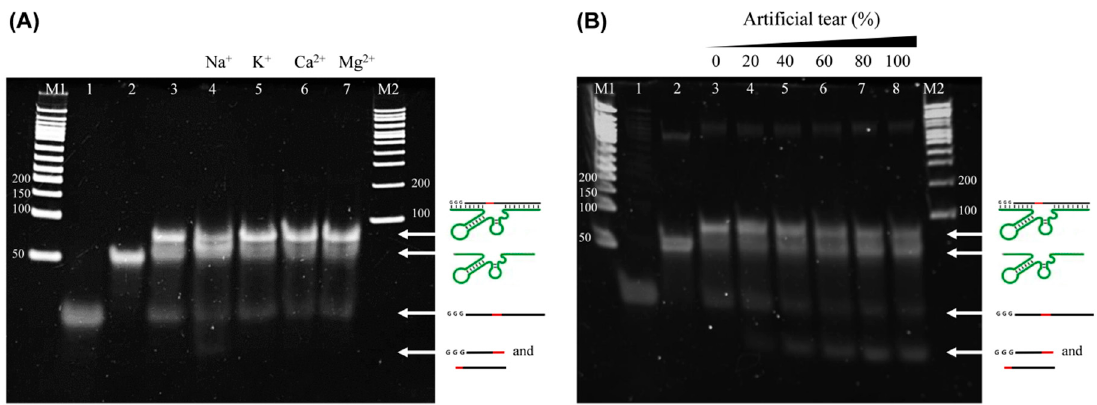
Figure 2. Gel electrophoretic images representing the cleavage of dsDNA (probes 1 and 2) at different ions ( A ) or at different concentrations of artificial tears ( B ). In ( A ) and ( B ), the first 3 lanes are the same; ssDNA probe 2 (lane 1), ssDNA probe 1 (lane 2), and dsDNA of probe 1/2 (lane 3). M1 and M2 indicate different DNA size markers. Lanes 4–7 in ( A ) represent the additions of Na + (lane 4), K + (lane 5), Ca 2+ (lane 6), and Mg 2+ (lane 7), whereas lanes 4–8 in ( B ) represent the additions of different concentrations of artificial tears (20, 40, 60, 80, and 100%). Gel electrophoresis was performed on a 6% native polyacrylamide gel at 25 mA for 20 min in 1 × TB and images were acquired on a UV transilluminator. The final concentration of monovalent and divalent ions was 135 mM.